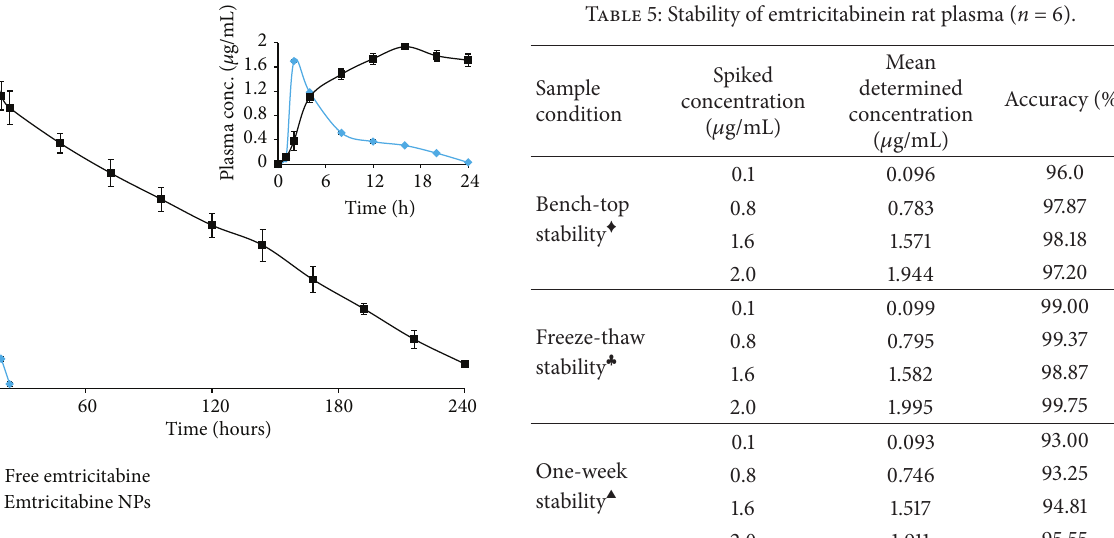
Figure 5: Plasma concentration-time curve of free emtricitabine and emtricitabine NPs after being orally administered in male Wistar rats (𝑛 = 6 , mean ± S.D ) . The inset shows the Plasma concentration-time curve in 24 h.